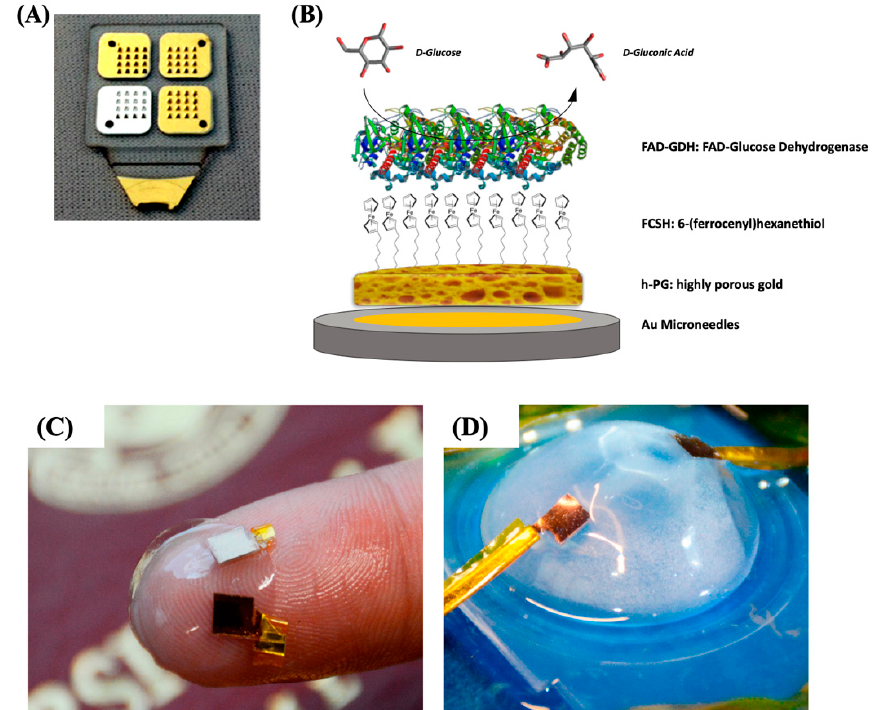
Figure 6. ( A ) Photo of four 4 × 4 microneedle arrays metallized with gold and silver and ( B ) schematic representation of the highly porous gold (h-PG) / 6-(ferrocenyl)hexanethiol (FcSH) / flavin adenine dinucleotide glucose dehydrogenase (FAD-GDH) / Au microneedle-based glucose biosensor. Photograph of the contact lens encapsulated enzymatic fuel cell (EFC; C ) and testing setup ( D ). Figure 6A,B are reproduced with permission from [100]. Copyright MDPI, 2019. Figure 6C,D are reproduced with permission from [105]. Copyright American Chemical Society, 2018.